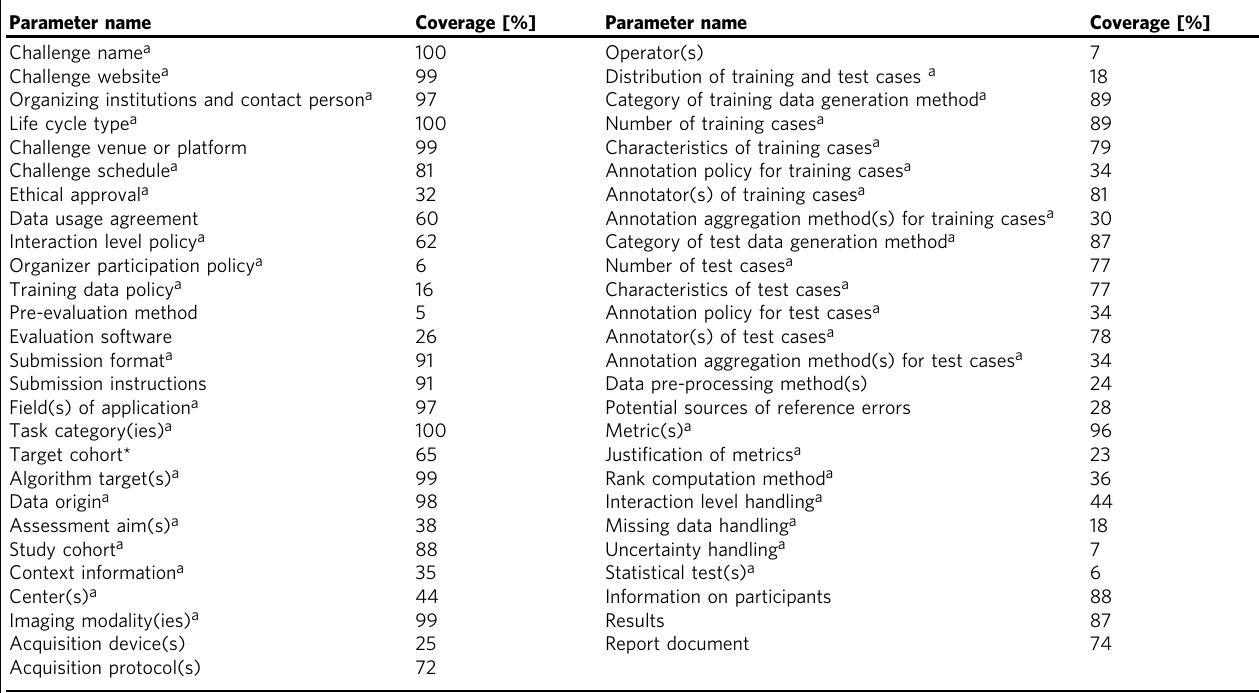
Table 1 List of parameters that characterize a challenge Parameter